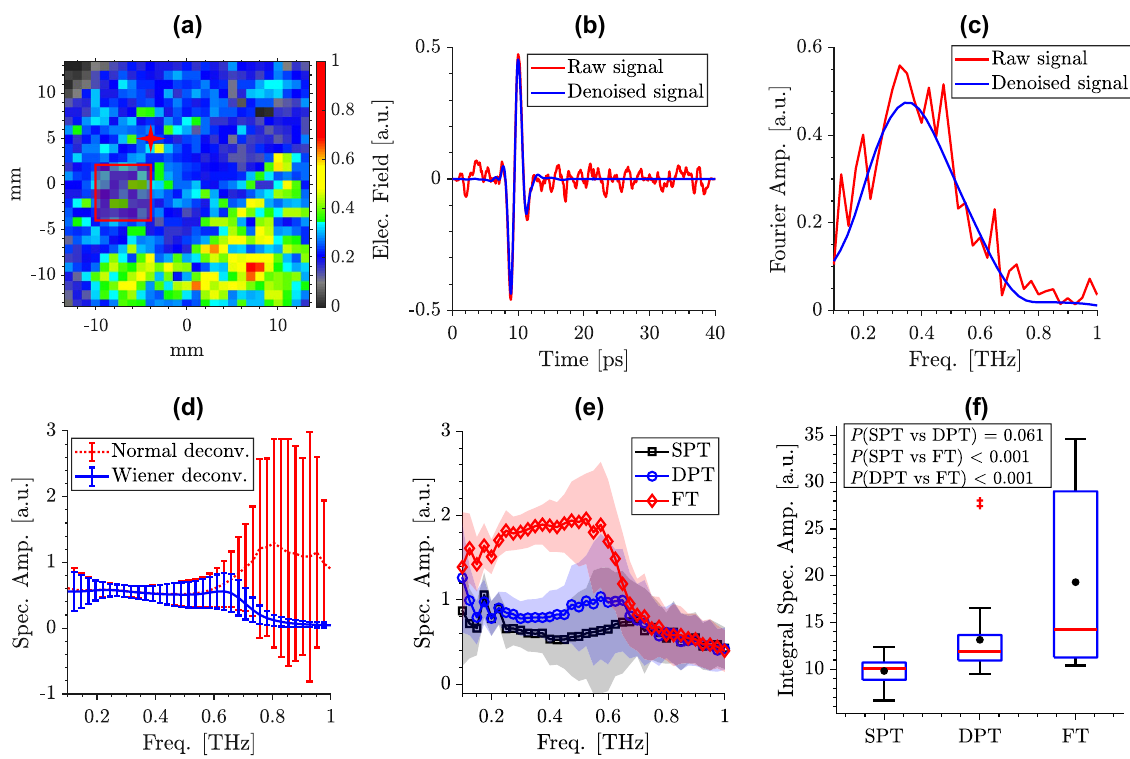
◦ 2 Figure 5. ( a ) A representative THz image of a burn created with 70 C scald device over a 27 by 27 mm field- of-view. The color axis shows the normalized area under the reflection spectral amplitude curves between 0.1 and 0.5 THz. ( b ) the wavelet denoising outcome in an example THz-TDS pulse selected from a pixel marked by the red star in ( a ), and ( c ) the Fourier amplitude of the signals shown in ( b ), ( d ) comparison between normal and Wiener deconvolution in a 4 × 4-pixel ROI shown using the red box in ( a ), where Wiener deconvolution effectively avoids the high-frequency spikes originated from an ill-posed deconvolution implementation, ( e ) the average spectral amplitude of reflectivity obtained after the Wiener deconvolution, along the standard deviation over the pixels of three ROIs, each selected randomly from a different burn grade example, i.e., SPT (black line, square markers), DPT (blue line, circle markers), FT (red line, diamond markers), (f) box plots comparing the area under the spectral amplitude curves in all burns (composed of thirty 4 × 4-pixel ROIs randomly selected from the burns in each group) over 0.1–0.5 THz, using a one-way ANOVA, the difference between SPT and FT groups ( p < .001), and DPT and FT groups ( p < .001) is statistically significant, while the p (SPT vs DPT) =